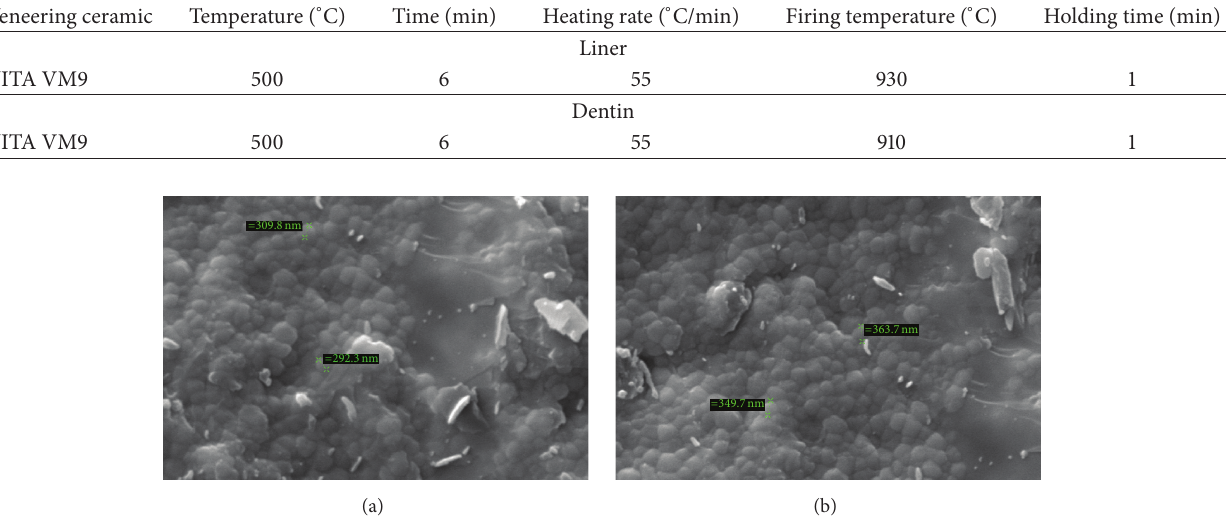
Figure1:(a)Microstructuralanalysisofgrainsizeofzirconiaspecimenswithoutautoclavetreatment(withoutartificialaging)underscanning electron microscope at the magnification of 30,000x. (b) Microstructural analysis of grain size of zirconia specimens with autoclave treatment (with artificial aging) for 5 hours under scanning electron microscope at the magnification of